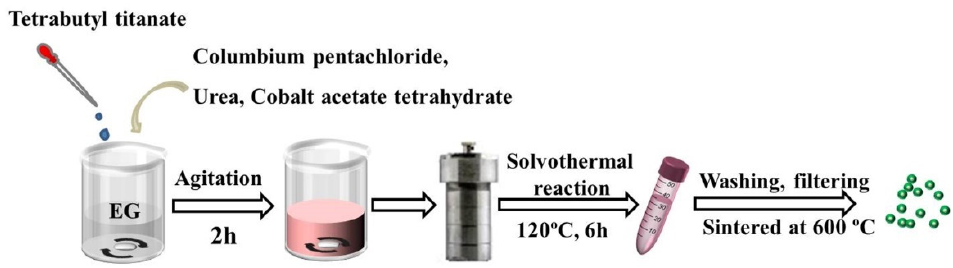
Figure 1. Illustration of the preparation process of Co 1 − x Nb x TiO 3 (x = 0, 0.02, 0.05, and 0.08).